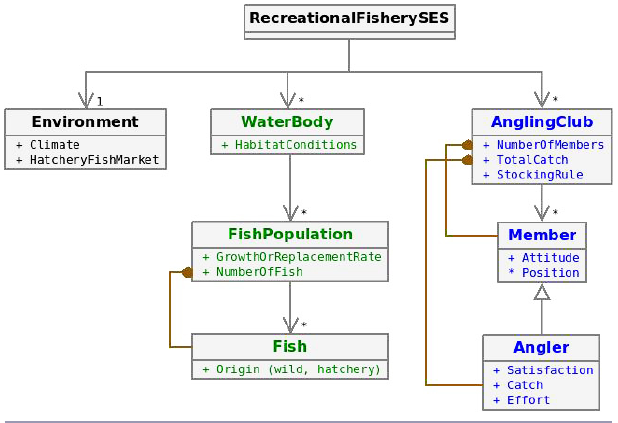
Fig. 4. The social-ecological system (SES) framework applied to the case of a recreational fishery. Boxes denote concepts, black arrows pointing down denote attribution relationships, black open arrowheads pointing up denote subsumption relationships, brown links denote aggregation relationships. A 1 indicates a one-to-one attribution relationship; an asterisk indicates a one-to-many attribution relationship. Concept names are indicated in boldface in the top part of the boxes; attributed variables are listed in the bottom part of the boxes. Process relationships and outcome metrics are not